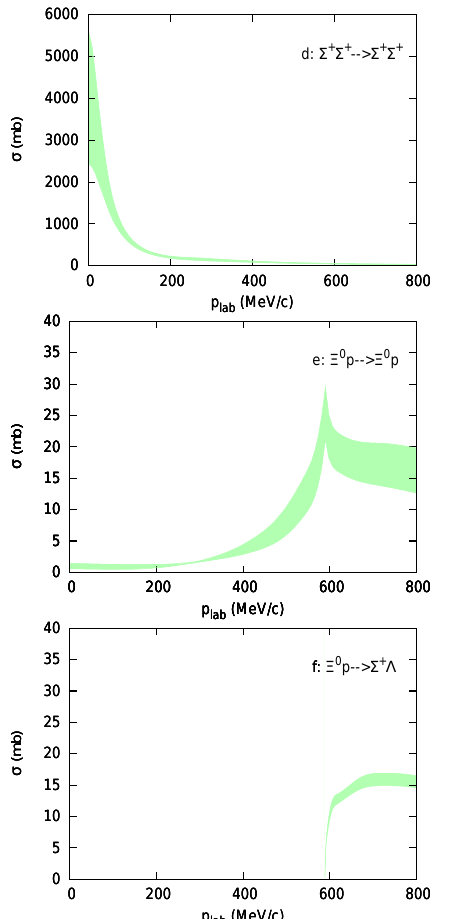
Fig. 3. YY and Ξ N integrated cross sections as a function of p lab . The band shows the chiral EFT for variations of the cuto ff Λ as discussed in the text.